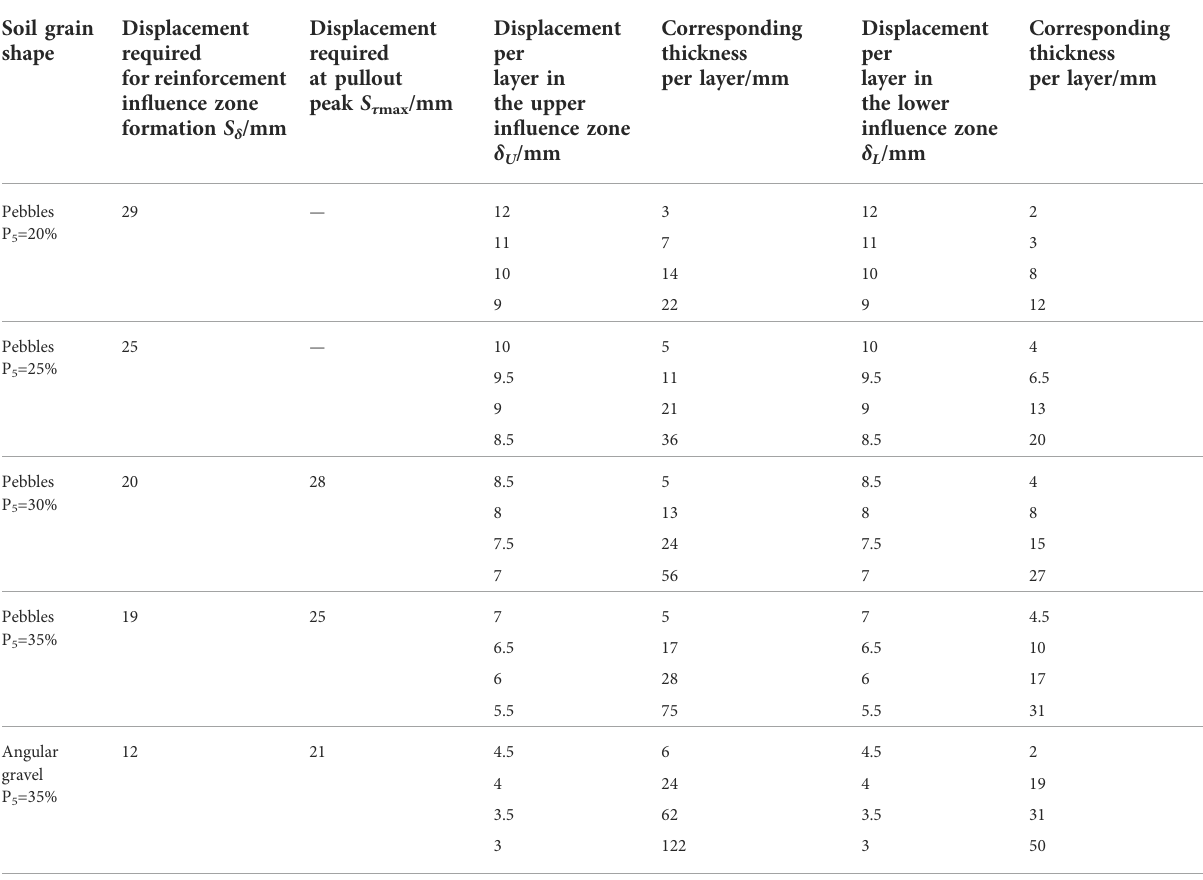
TABLE 6 Displacement and thickness of each layer under different types of soil materials (at the pullout peak).